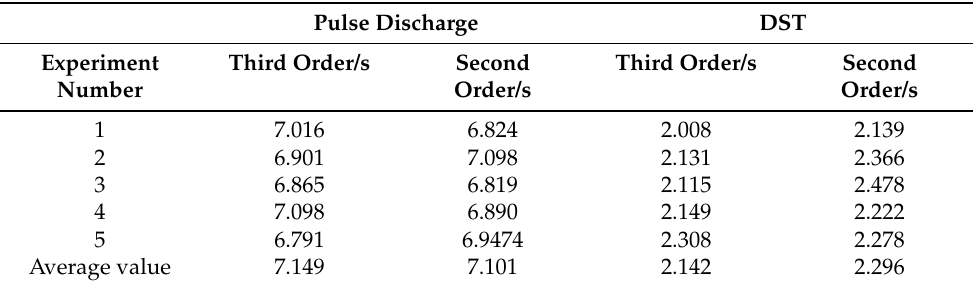
Figure 7. Different models under different working conditions: ( a ) MAE, ( b ) RMSE. Table 2. Algorithm convergence